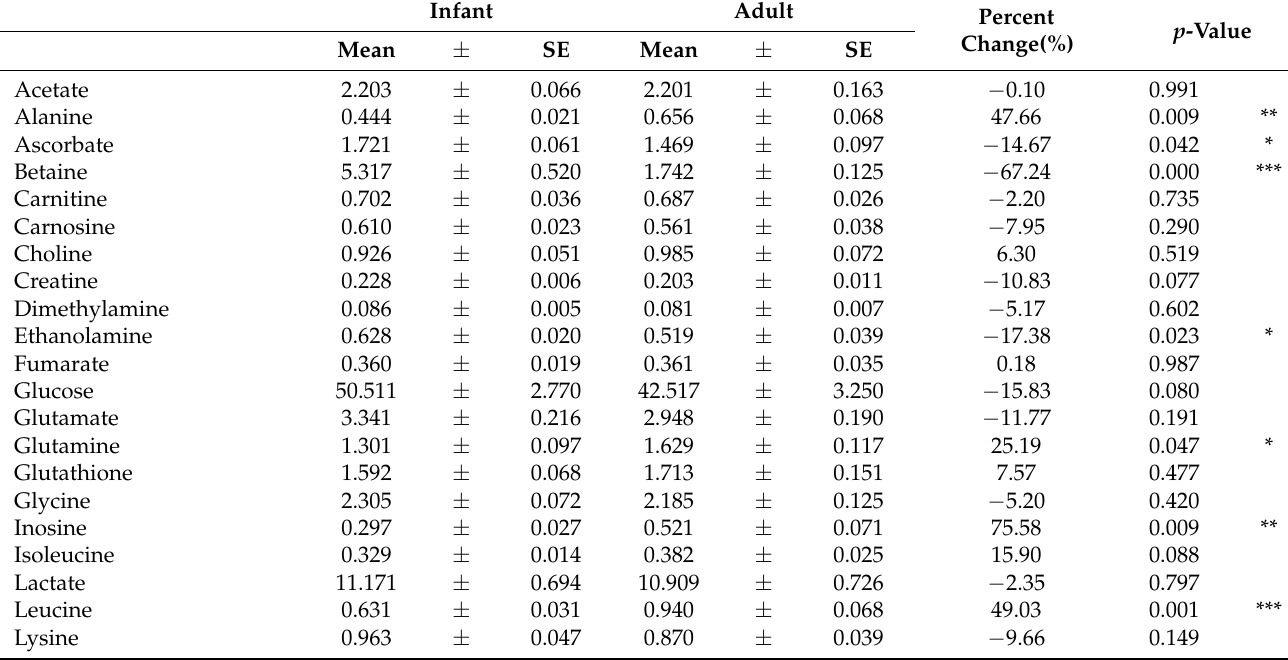
Table 2. Relative concentrations of metabolites acquired using 1 H-NMR spectroscopy from